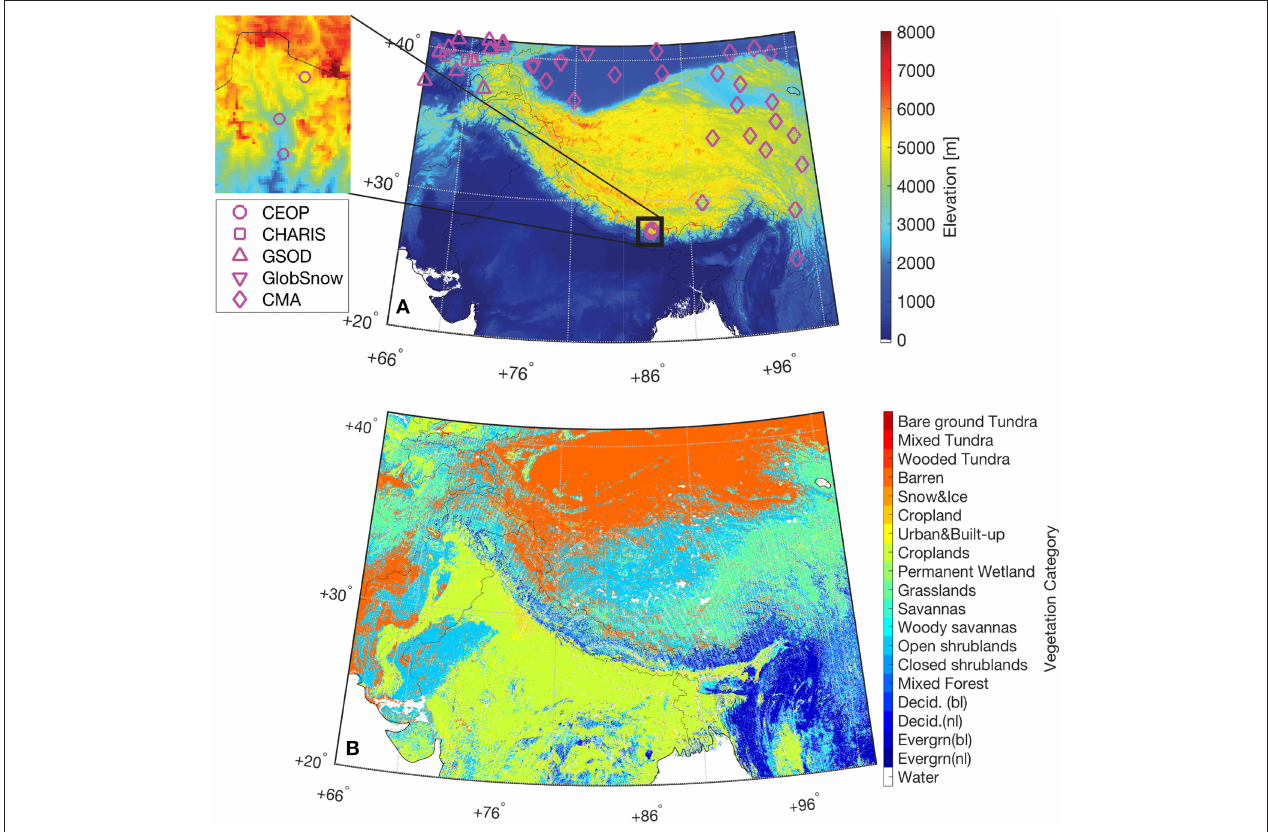
FIGURE 1 | (A) Reprocessed Shuttle Radar Topography Mission elevation map on the 0.01 ◦ model grid. Grid cells used during assimilation evaluations are marked in magenta. Again, GlobSnow is a product, rather than in-situ measurements, but we utilize GlobSnow product in a point-scale manner as discussed in section 4.